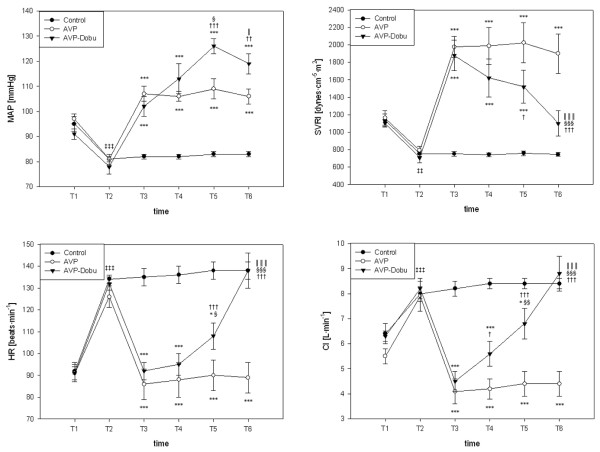
Changes in mean arterial pressure (MAP), systemic vascular resistance index (SVRI), heart rate (HR) and cardiac index (CI). AVP, arginine vasopressin; AVP-Dobu, group treated with AVP and dobutamine; T1, healthy baseline; T2, endotoxemic baseline; T3, AVP or placebo; T4, T5, T6, AVP + dobutamine 2, 5 and 10 μg kg-1·min-1 or placebo, respectively. *p < 0.05 versus control, ***p < 0.001 versus control, †p < 0.05 versus AVP, ††p < 0.01 versus AVP, †††p < 0.001 versus AVP, ‡‡‡p < 0.001 versus T1, §p < 0.05 versus T4, §§p < 0.01 versus T4, §§§p < 0.001 versus T4, ∥p < 0.05 versus T5, ∥∥∥p < 0.001 versus T5.